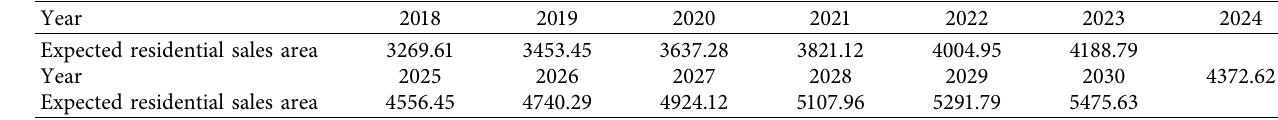
Table 10: Forecast value of expected residential sales area in Wuhan.